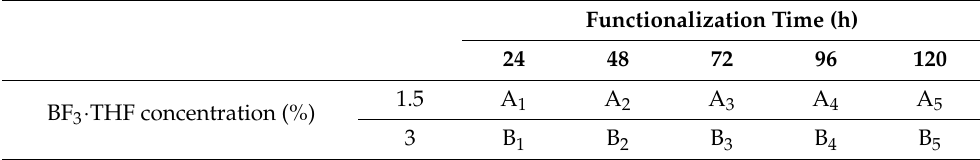
Table 1. Sample naming depending on the functionalization time and concentration of boron fluoride tetrahydrofuran (BF 3 · THF)